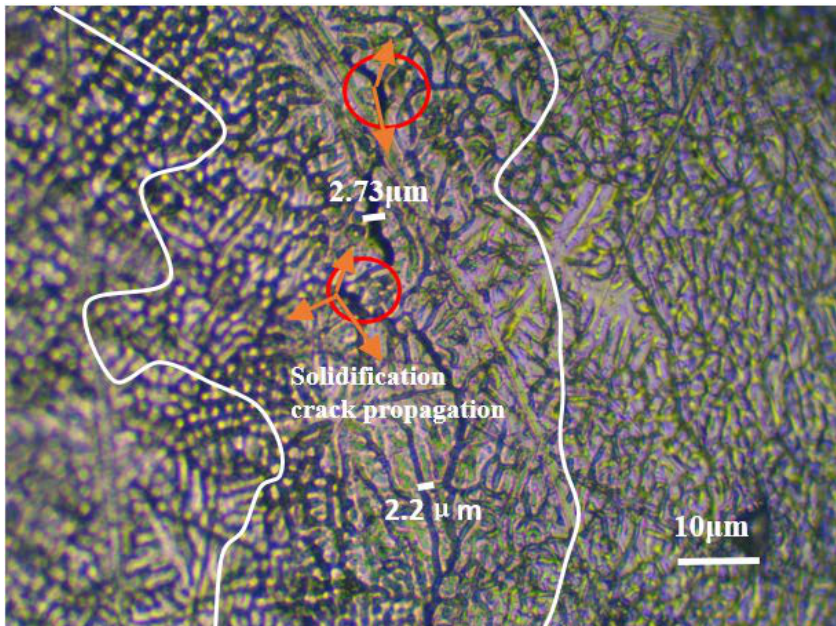
Figure 3. Topography of the solidified cracks.